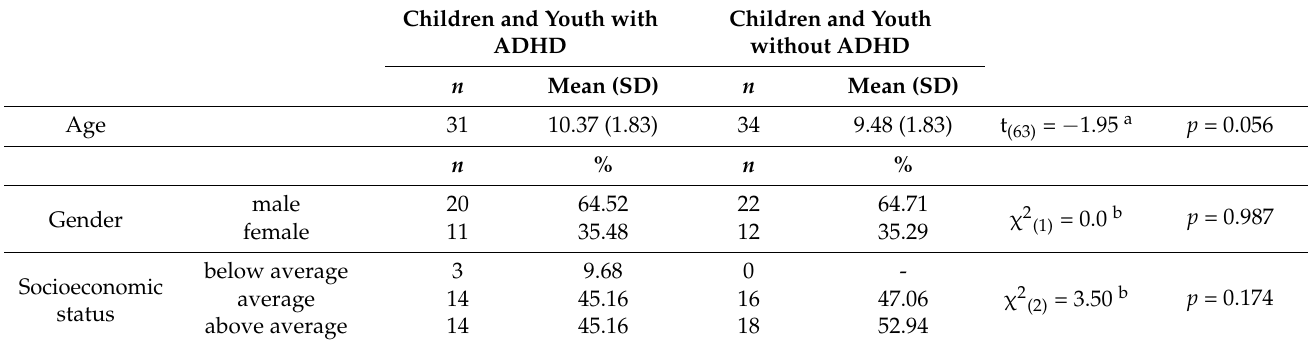
Table 1. Demographic characteristics of the